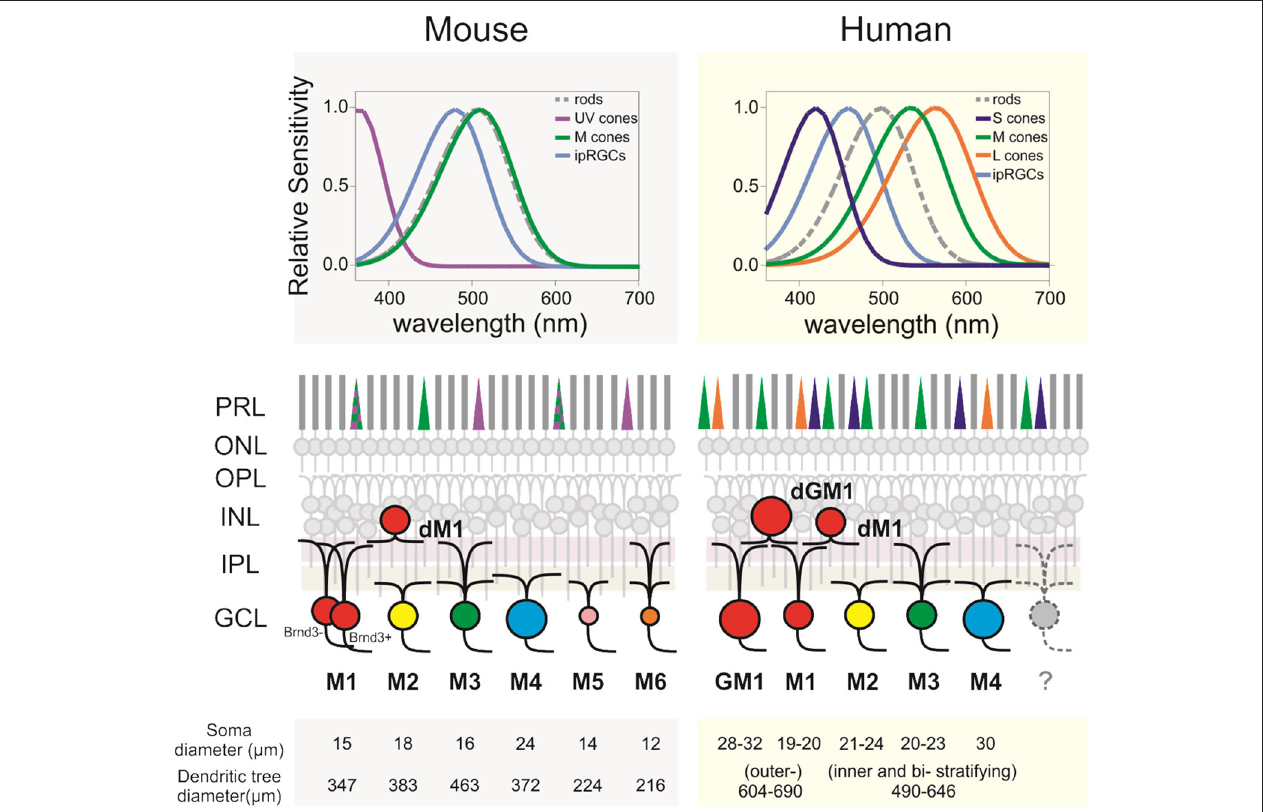
FIGURE 1 | ipRGCs in the mouse and human retinas. (Upper panels) Relative spectral sensitivity of the rods, cones, and ipRGCs. (Middle panels) Diagram of murine and human retinas displaying the differences regarding the morphological subtypes of ipRGCs, their IPL dendritic stratification, and outer retina photoreceptors. (Lower panels) Morphological comparison between subtypes and species. Soma and dendritic tree measurements are rounded to the closest integer. Mouse data are from Sondereker et al. (21) that compiled them from literature. Human data are from Esquiva et al. (22), Hannibal et al. (23), Liao et al. (24), and Nasir-Ahmad et al. ( 25). GM1, gigantic M1; dM1, displaced M1; dGM1, displaced gigantic M1; PRL, photoreceptors layer; ONL, outer nuclear layer; OPL, outer plexiform layer; INL, inner plexiform layer; IPL, inner plexiform layer; GCL, ganglion cells